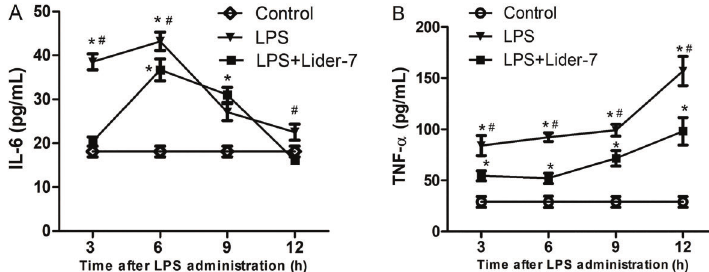
pretreated with Lider-7 had signi fi cantly lower levels of IL-6 (LPS + Lider-7 group vs LPS group: P o 0.05 at 3, 6 and 12 h) and of TNF- a (P o 0.05 at 3, 6, 9, and 12 h)